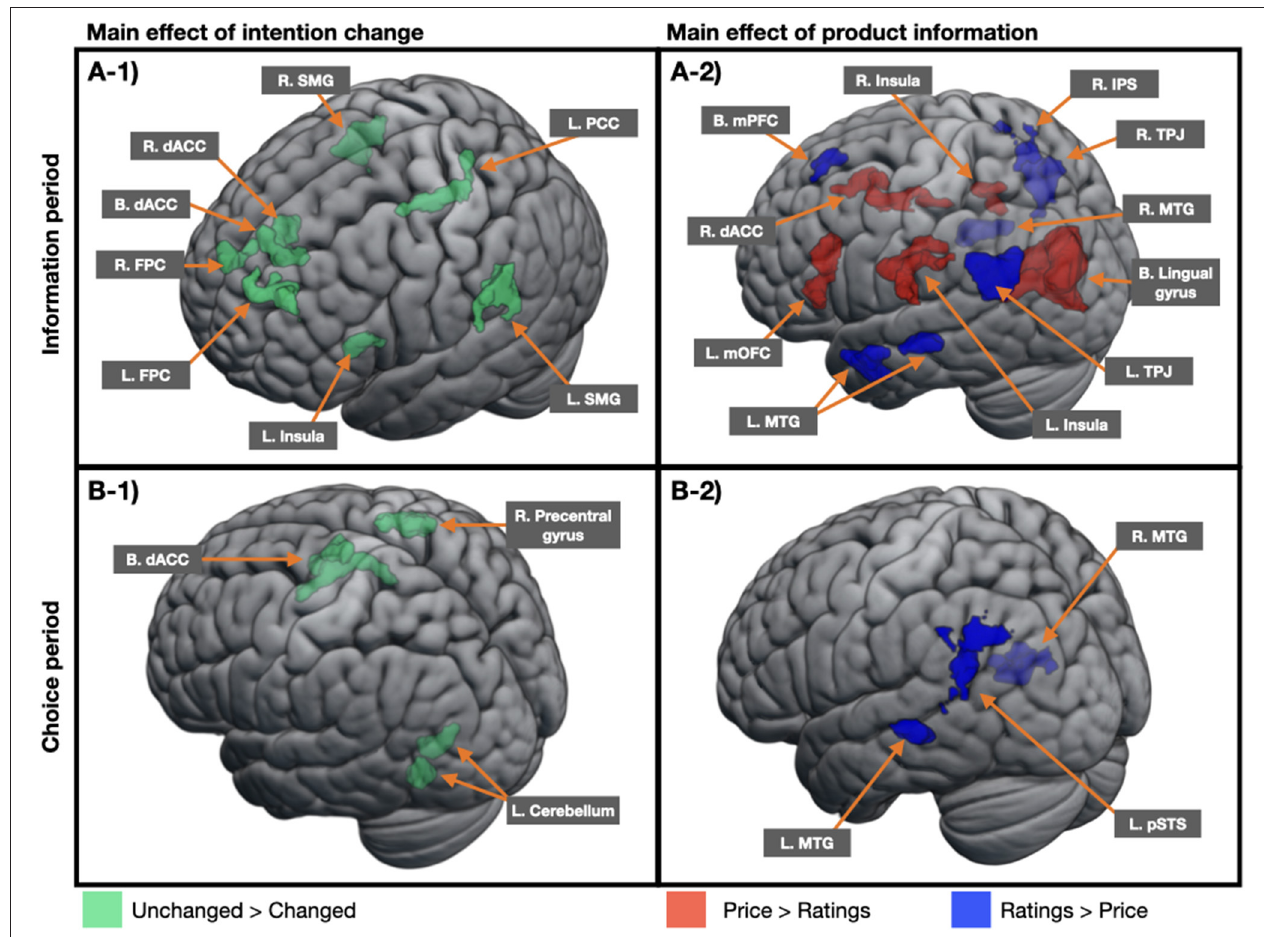
FIGURE 2 | An illustration of neural regions showing the main effects of intention change and product information in the categorical analysis. All regions showing the main effect of intention change were more activated in the unchanged condition than in the changed condition at both the information period (A-1) and choice period (B-1) . (B) The regions showing the main effect of product information were mixed with those that responded more to the price condition and those that responded more to the rating condition at the information period (A-2) , but were more activated in the rating condition than in the price condition at the choice period (B-2) . B, bilateral; L, left; R, right; FPC, frontopolar cortex; dACC, dorsal anterior cingulate cortex; PCC, posterior cingulate cortex; SMG, supramarginal gyrus; mOFC, medial orbitofrontal cortex; mPFC, medial prefrontal cortex; MTG, middle temporal gyrus; TPJ, temporoparietal junction; IPS, intraparietal sulcus; pSTS, posterior superior temporal